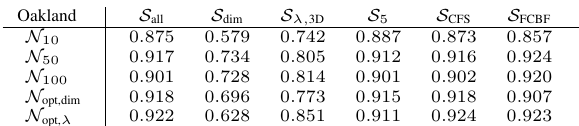
Table 8: Overall accuracy for RF-based classification using dif- ferent neighborhood definitions and different feature sets.